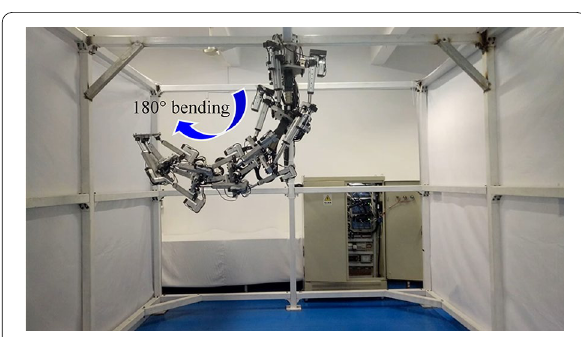
Figure 22 180° bending configuration of HRETR